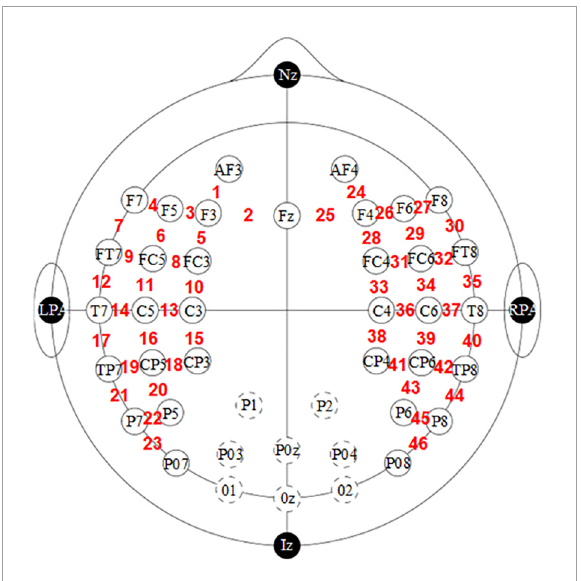
FIGURE1 Functional near-infrared spectroscopy optode (sources and detectors with circle in black) and channel (digital in red) localization in the experimental setup. The dotted line indicates the graph with the deleted occipital